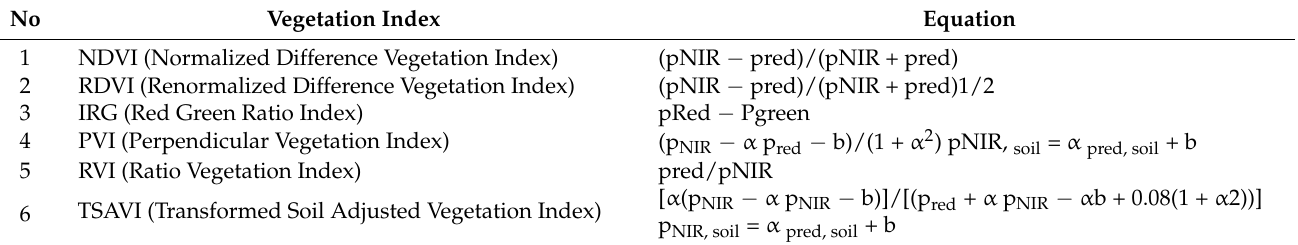
Table 1. Example of multispectral vegetation indices used in the study of Agapiou and Sarris in 2018